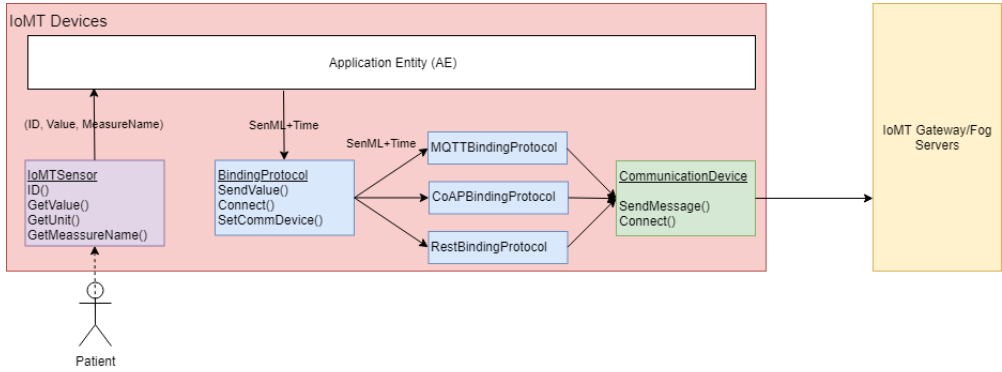
Figure 6. Development framework operation for an IoMT